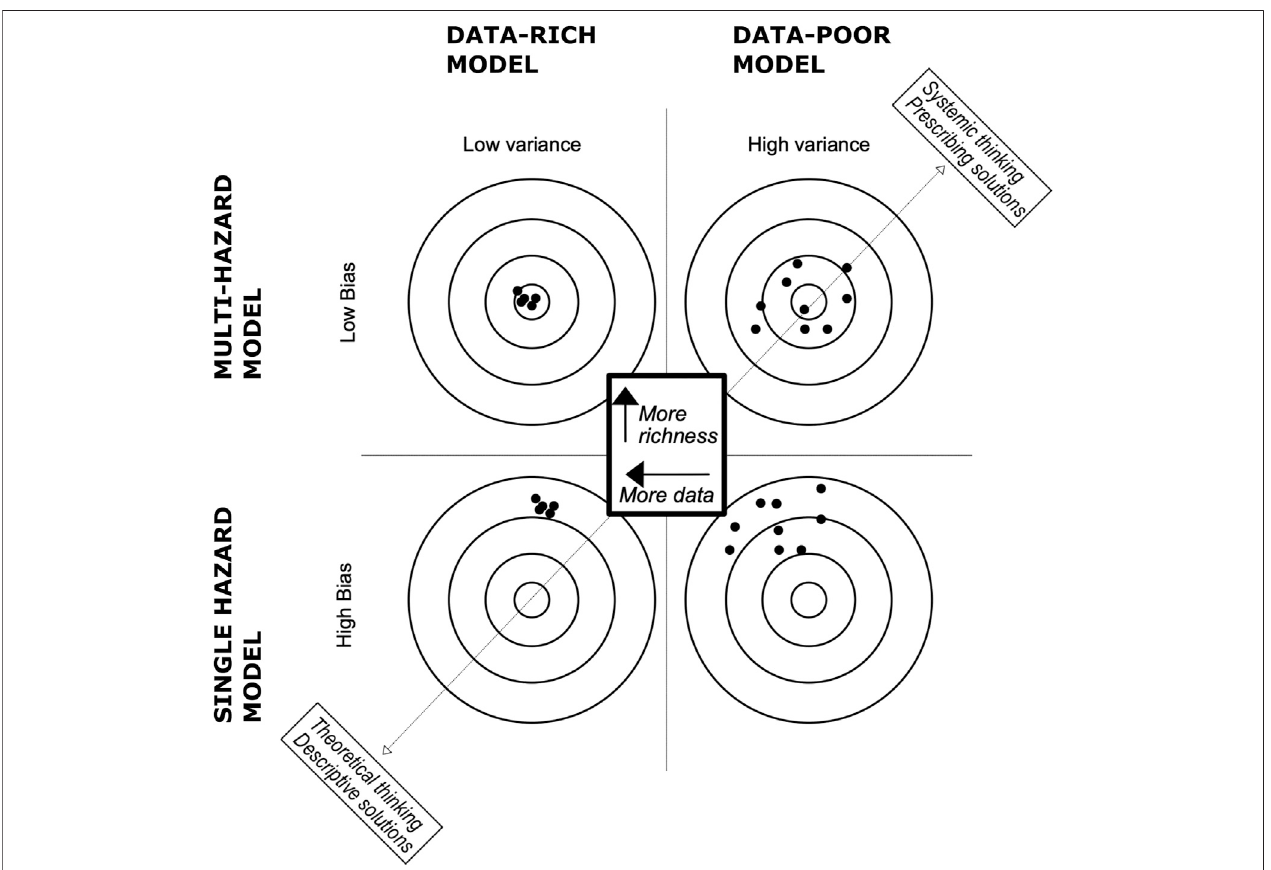
FIGURE 2 | Representation of the bias-variance tradeoff in a multi-hazard